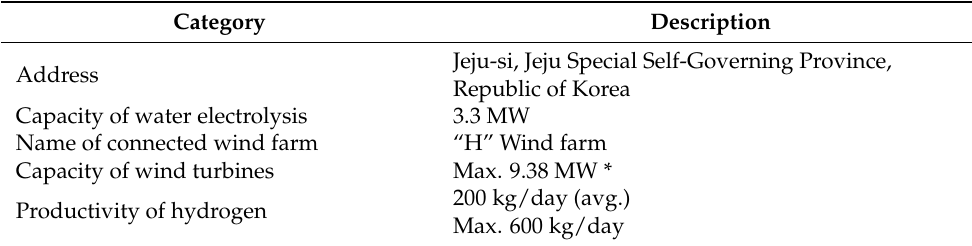
Table 2. Specification for P2G hydrogen-production system.